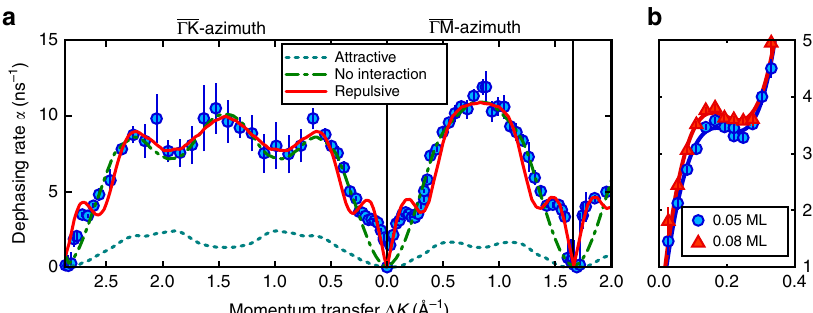
Fig. 4 Comparison of the experimental dephasing rates α ð Δ K Þ with kinetic Monte Carlo simulations and the coverage dependence of α ð Δ K Þ . a Momentum transfer dependence α ð Δ K Þ for the diffusion of H 2 O on Bi 2 Te 3 (111) at 150K. Experimental results for a coverage of 0.05ML are shown as discrete points. The red solid line shows α ð Δ K Þ as extracted from a kinetic Monte Carlo simulation where repulsive dipole – dipole forces between the individual water molecules are included. Attractive interactions (turquoise dashed line) give dephasing rates much lower than the experiment, while diffusion without forces (green dash-dotted line) does not reproduce the structure around the zone centre (see text). b A close-up of the experimental dephasing rates in Fig. 2 (b) along the Γ M -direction for two coverages: 0.05ML, (red line and points), and 0.08ML (blue line and points). The observed increase in dephasing rate below 0.3 Å − 1 con fi rms the presence of repulsive interactions. The error bars correspond to the con fi dence bounds (1 σ ) of α ð Δ K Þ